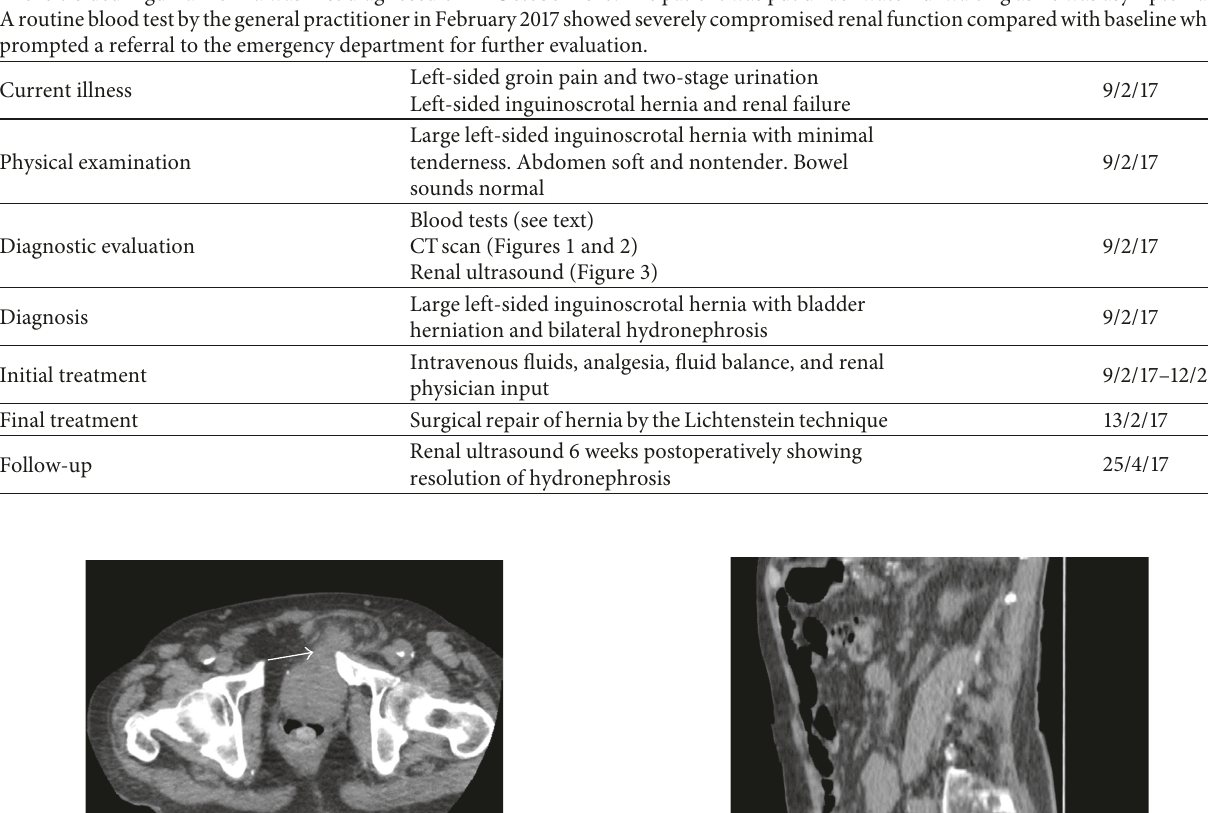
Table 1: Case timeline.